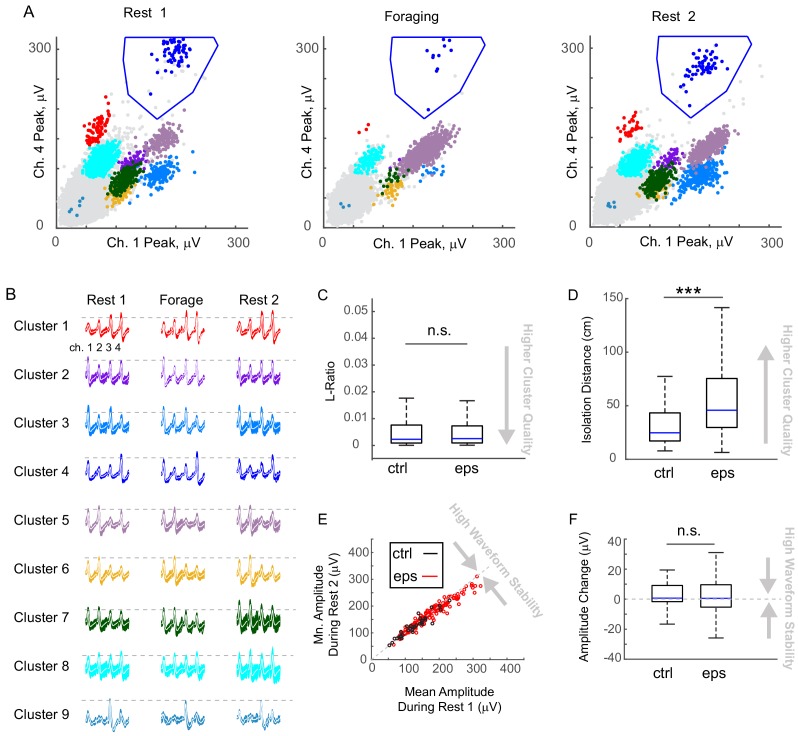
Spike waveforms are equally stable in control and epileptic animals and cluster quality is high in both groups.(A) Scatterplots of spike amplitudes on two of the four recording channels (ch1, ch4) from a tetrode different from the one shown in the main Figure 4, but also implanted in an animal with epilepsy. Each colored cluster corresponds to spikes from one cell. In this projection (peaks from ch1, peaks from ch4), the cluster denoted by dark blue was clearly distinct from the noise and far from other clusters (cells), therefore boundaries were drawn around the cluster to define it. The gray dots within these boundaries were excluded by boundaries set in a different projection. All boundary definitions were assigned manually, i.e. we did not employ automated spike sorting. Note, the relationship of spike clusters to other cells and the noise did not change for a cluster over the recording session. (B) For each cluster shown in (A), the waveforms recorded on each tetrode channel (1 – 4) are shown for each behavioral period, with average waveforms superimposed in white. Dotted lines are drawn to mark the height of the average waveform at its largest in Rest 1, and extended so that a by-eye comparison can be made across the behavioral periods. Although different firing rates can be observed during different behavioral periods, the relationship of the spike amplitude across channels remains constant. This consistency is an indicator of a stable tetrode position in relation to the cell layer. (C) L-Ratio was the same for clusters recorded in control (n = 203; median, IQR, 0.0023, 0.0009–0.0076) and in epileptic animals (n = 795; median, IQR, 0.0025, 0.0009 -. 0073) (p = 0.54, Wilcoxon Rank Sum Test, z-value = −0.6). (D) Isolation distance was large in control and epileptic animals (98.7% of clusters had isolation distance > 10 cm). In epileptic animals, the isolation distance (n = 795; median, IQR, 48.6, 32.6–78.3) was larger than in controls (n = 203; median, IQR, 24.7, 17.1–43.3) (p = 5.1 * 10−29, Wilcoxon Rank Sum Test, z-value = −11.2). (E) for each cell, the channel that recorded the largest waveform in the first session (e.g., channel 4 for cluster one shown in (B)) was selected, and the average waveform is plotted for Rest one versus Rest 2. Note that all cells lie close to the identity line, confirming that waveforms were stable across the entire recording. (F) Changes in waveform amplitude from the first to the second rest session were the same for cells recorded in control (n = 35; median, IQR, 0.7–1.6 – 9.1) and epileptic animals (n = 177; median, IQR, 1.8,–4.1 – 10.8)(not significant, Wilcoxon Rank Sum Test, p = 0.57, z-value = −0.57). The results in (C) – (F) indicate that cluster quality does not differ significantly between control and epileptic animals, and when there is a significant difference it is toward higher cluster quality in epileptic animals.